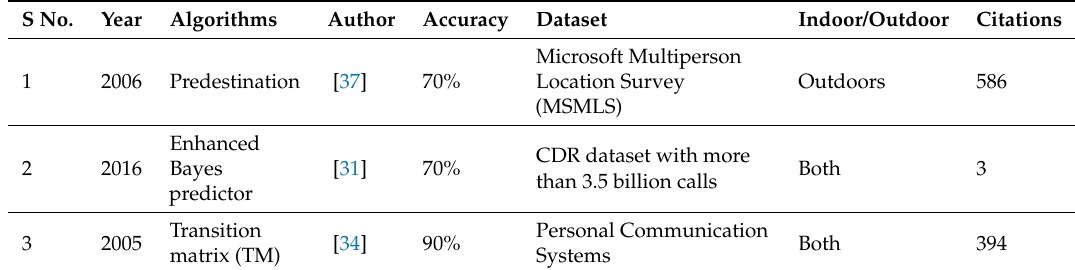
Table 5. Bayesian